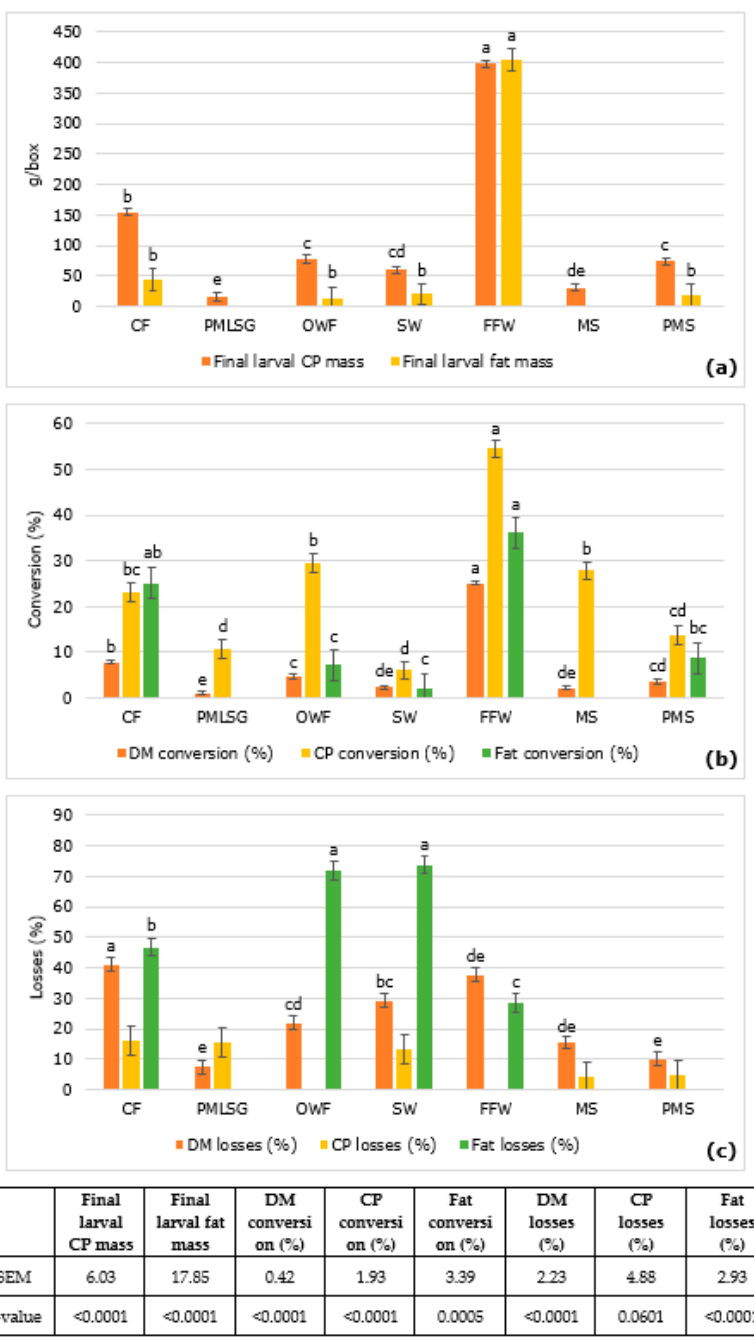
Figure 3. The mean values ± SEM of the crude protein and fat masses (g/box) ( a ), conversions (%) ( b ) and losses (%) ( c ) of larvae reared on different substrates 1 (based on dry matter). Means with different letters in a row are significantly different (two-way ANOVA followed by Tukey’s post hoc test analysis p < 0.05). Chicken feed (CF; control diet), pig manure slurry mixed with roadside silage grass (PMLSG), organic wet fraction (OWF), slaughter waste (SW), fast food waste (FFW), mushroom stems (MS) and pig manure solid (PMS). Missing data were below the limit of detection.